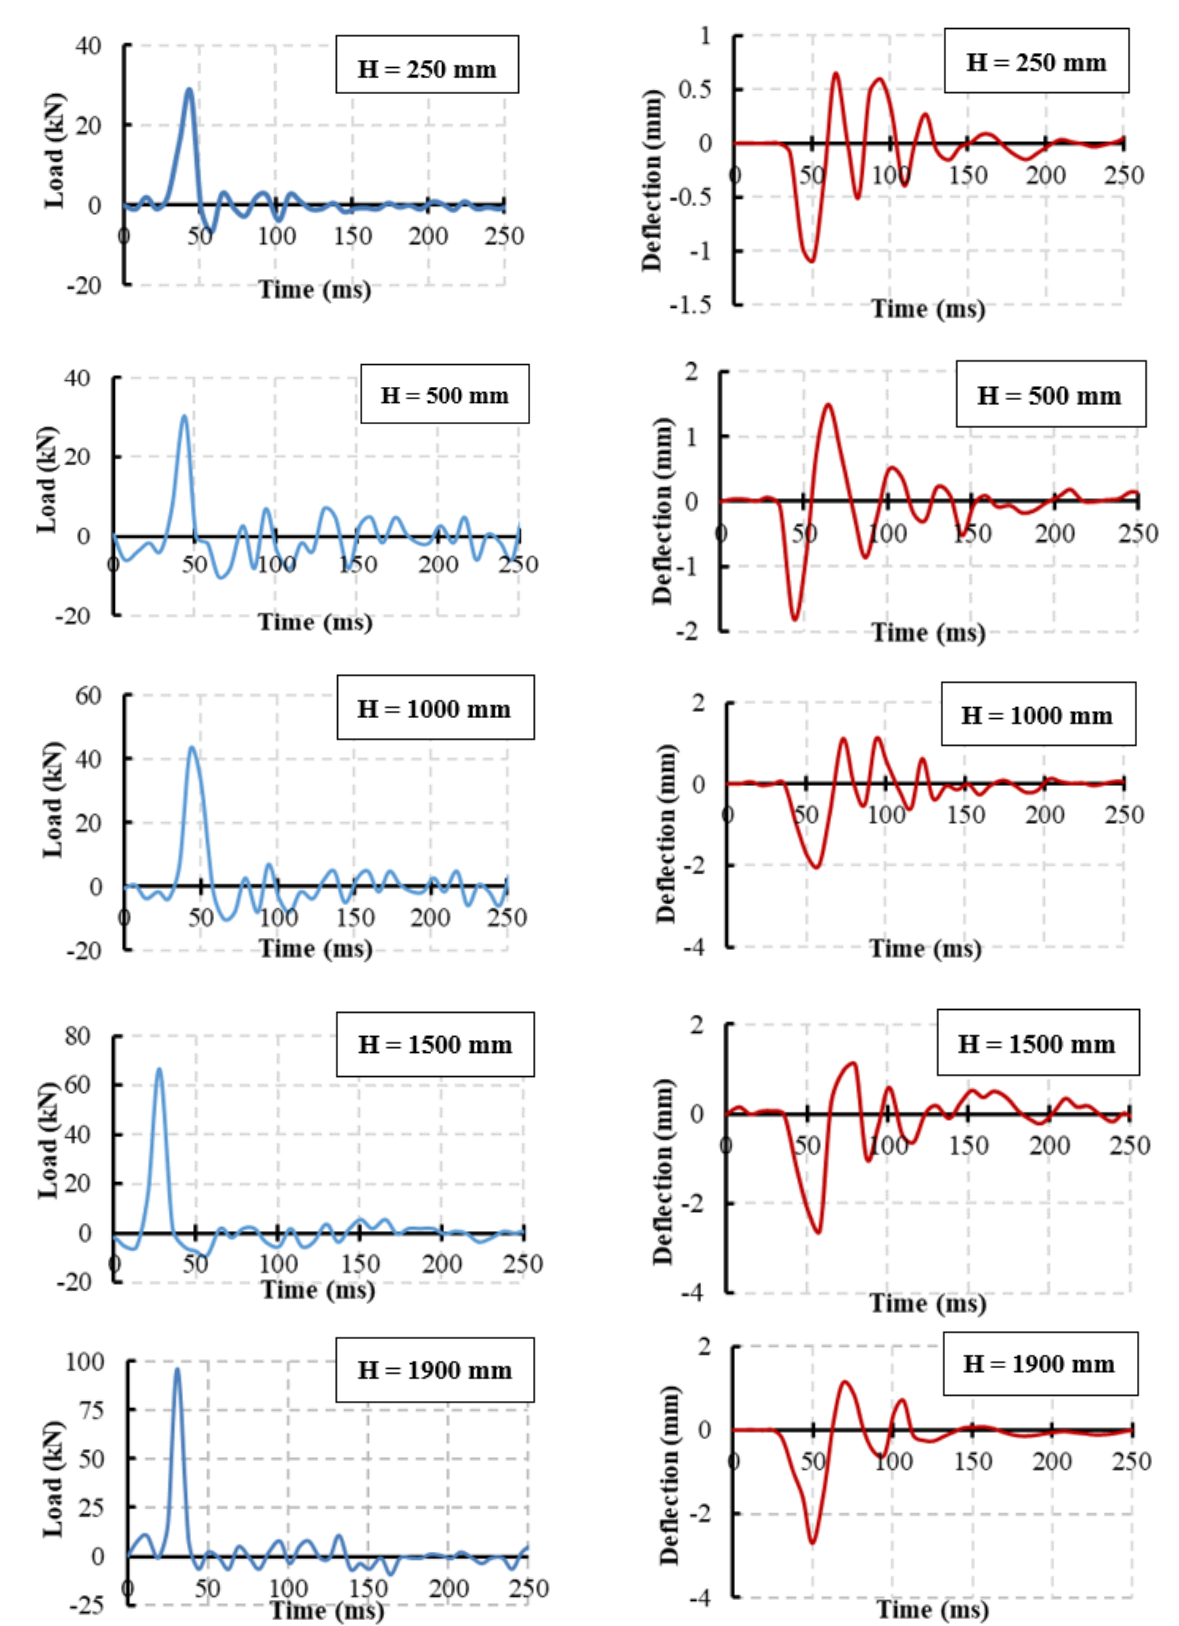
Figure 8. The specimen NR ‐ I’s impact force and mid ‐ span deflection time histories.